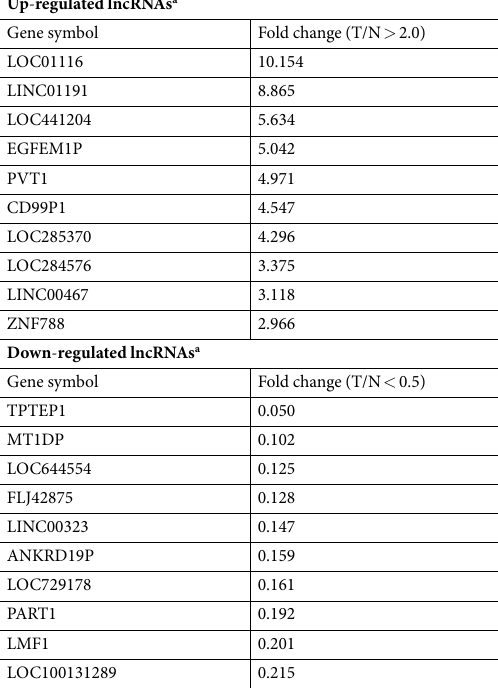
Table 1. Dys-regulated lncRNAs in brain tumor. a Top 10 ranking of up- and down-regulated lncRNAs in clinical specimens were listed. (T/N fold change > 2.0 or < 0.5).